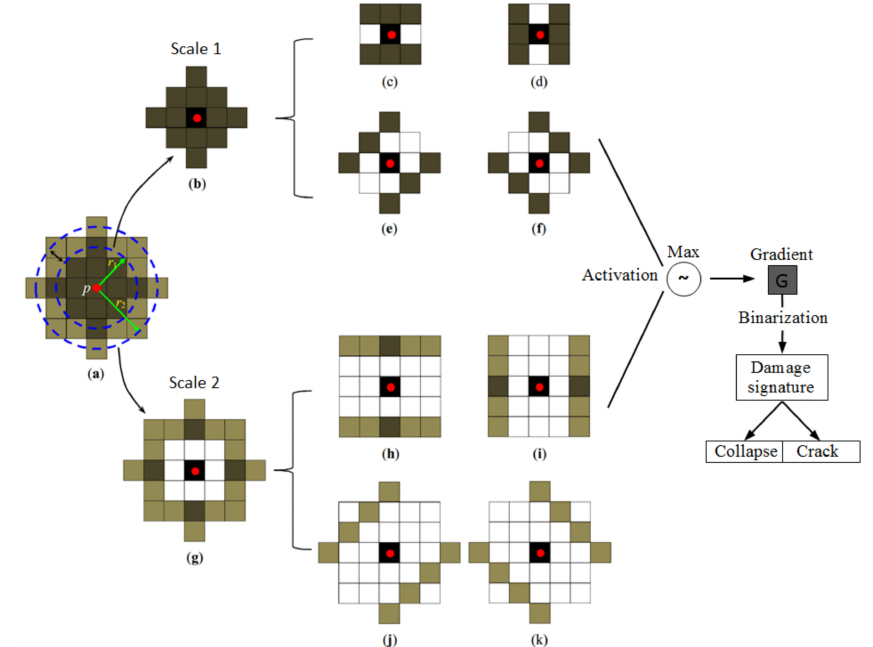
Figure 7. Multiscale architecture of the proposed self-adaptive and multiscale gradient operator (SMGO) and damage signature generation. Scope of the area surrounding a cell in ( a ) Scales 1 and 2 for gradient computation and ( b ) Scale 1. ( c – f ) Kernels of the gradient computation in Scale 1. ( g ) Scope of the area surrounding a cell in Scale 2. ( h – k ) kernels of the gradient computation in Scale 2. The white and nonwhite grids denote the null and nonzero values,